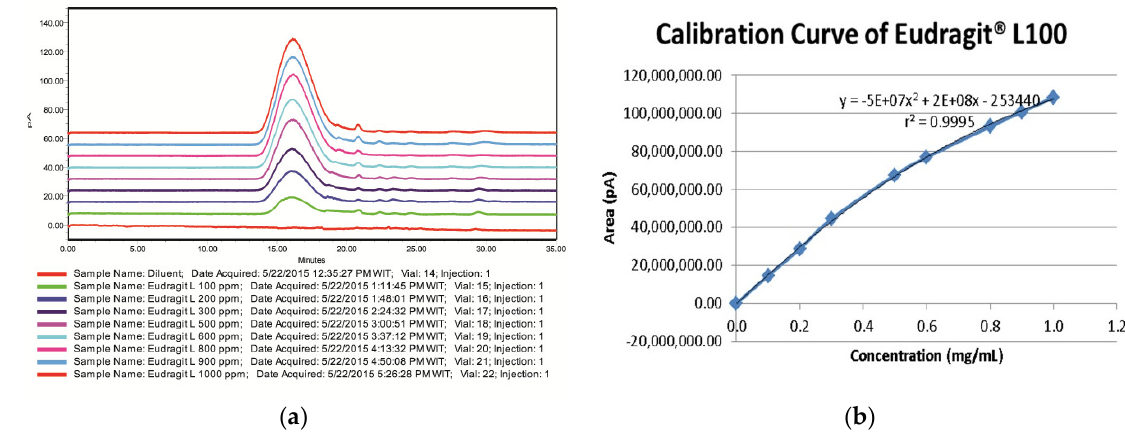
Figure 3. ( a ) Overlay chromatograms and ( b ) calibration curve of Eudragit ® L100 series concentration solutions (0.1–1.0 mg/mL).